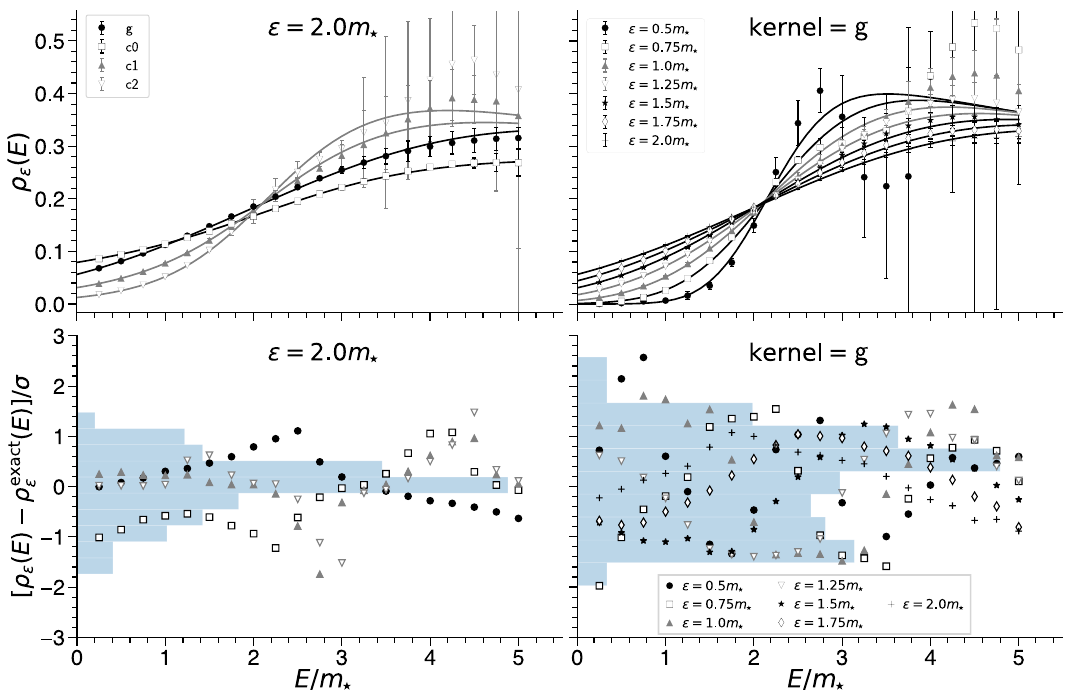
Figure 6 . Summary of the continuum extrapolated values with statistical and systematic errors combined in quadrature as described in the text. Top left : all four smearing kernels are plotted for a large smearing radius (cid:15) = 2 m ? together with the exact results including 2-, 4-, and 6-particle contributions shown as solid lines. Bottom left : the ‘pull’ between the numerical and exact results for the same data. The variation of the points (as also illustrated with the histogram built by counting the number of points in each vertical bin) indicates that the numerical and exact results are consistent at the 2- σ level. Top and bottom right: same type of plots but for a variety of smearing widths with the Gaussian smearing